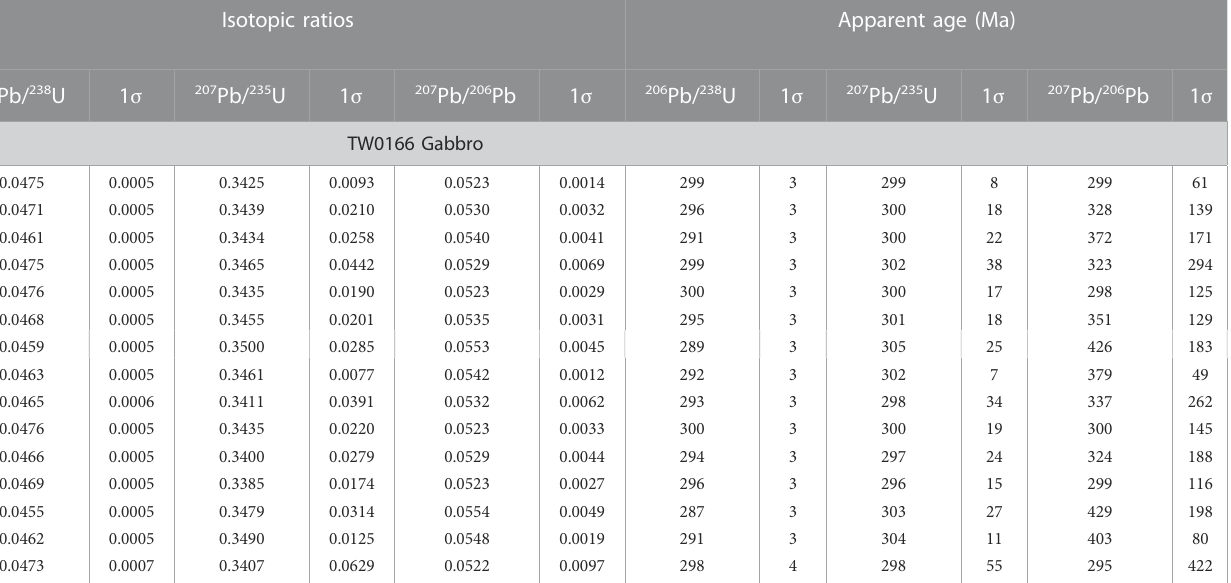
TABLE 1 LA-MC-ICP-MS zircon U-Pb isotopic analysis of the gabbro in Diyanmiao ophiolite. Spots